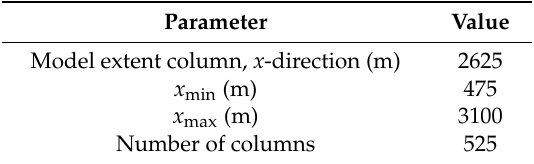
Table 2. Model extent in the x -direction for models 3 and 4. All other parameters are shown in Table